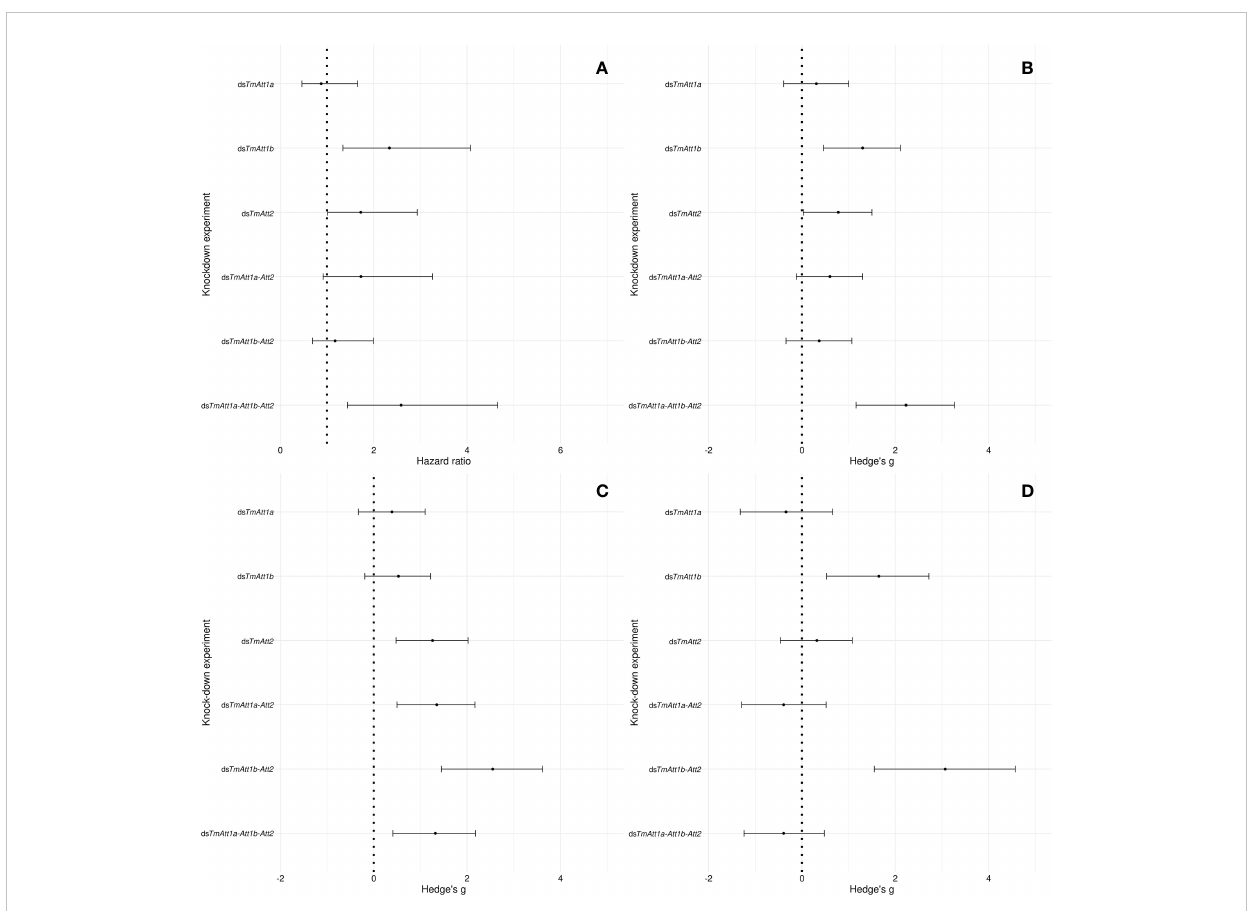
FIGURE 7 Forest plot representing the effects of the single, double, or triple knockdown of the AMP genes of interest on (A) survival of Tenebrio molitor females infected by Pseudomonas entomophila and (B) the number of P: entomophila CFU retrieved from females at 1-day, (C) 2-days, and (D) 3- days post-infection. In case of the survival, the effect size is calculated as the hazard ratio (HR) between knockdown and ds EGFP control groups (A) . In case of CFU counts (B – D) , it is calculated as the Hedge ’ s g between knockdown and ds EGFP control groups. Dots represent the HR and Hedge ’ s g, and the horizontal bars extend from the lower limit to the upper limit of the 95% con fi dence interval (95CI). An overlap of the 95CI with 1 (vertical line) means the knockdown has no effect on survival compared to control. A HR < 1 indicates a reduction in the hazard, whereas a HR > 1 indicates an increase in hazard In the knockdown compared to control, an overlap of the 95CI with 0 (vertical dotted line) indicates no signi fi cant effect of the knockdown treatments compared to control on CFU count, a positive value indicates a positive effect of the knockdown on CFU count, whereas a negative value indicates a negative effect of the knockdown on CFU count compared to